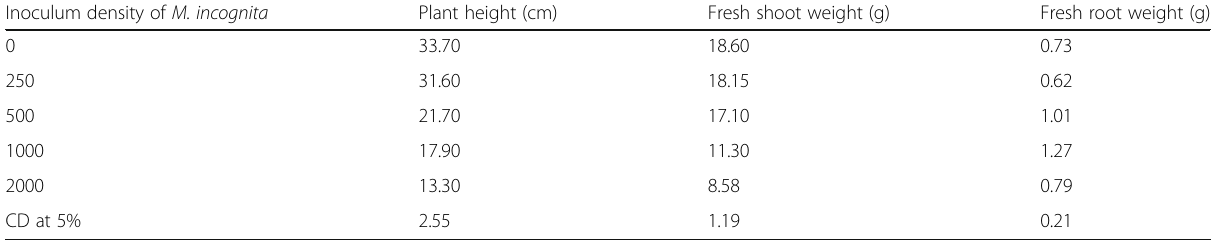
Table 2 Effect of different levels of Meloidogyne incognita in presence of Fictor composticola on growth parameters of cucumber Inoculum density of M. incognita